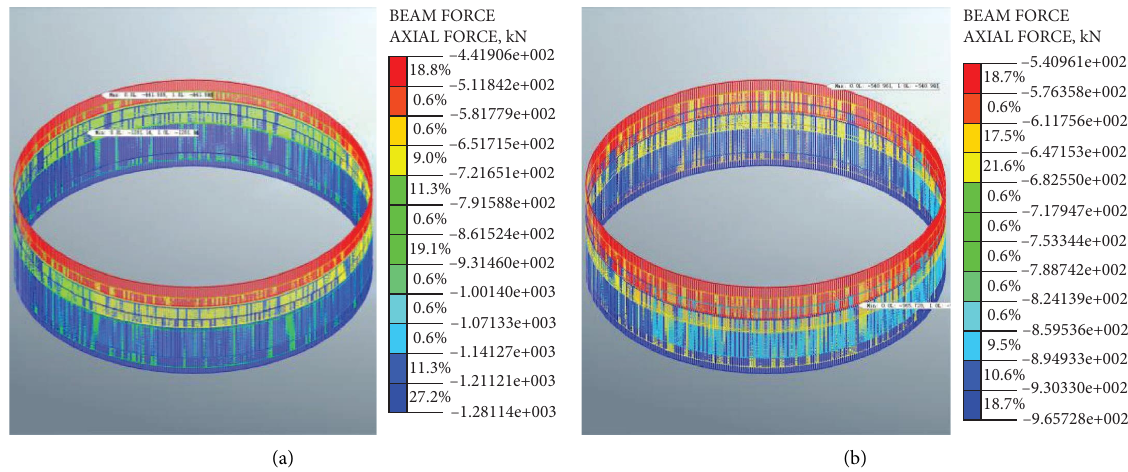
Figure 33: Working condition 6 lining axial force (a) without pore water pressure and (b) with pore water pressure applied.